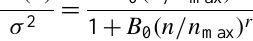
Figure 2. Nighttime vertical profiles of (a) virtual potential temperature (  Fig. 2. Nighttime vertical profiles of (a) virtual potential temperature ( θ v ) , (b) specific (q) and relative (RH) humidity, (c) wind speed and direction, and (d) vertical gradient of θ v and bulk Richardson number ( Ri B ) for the radiosonde flight launched at 01:25PST of 9 July, 2009. relative ( RH ) humidity, (c) wind speed and direction, and (d) vertical gradient of  Horizontal dashed line represents nocturnal boundary layer height ( h Richardson number ( Ri ) for the radiosonde flight launched at 01:25 PST of 9 July, 2009. B Horizontal dashed line represents nocturnal boundary layer height ( h ).